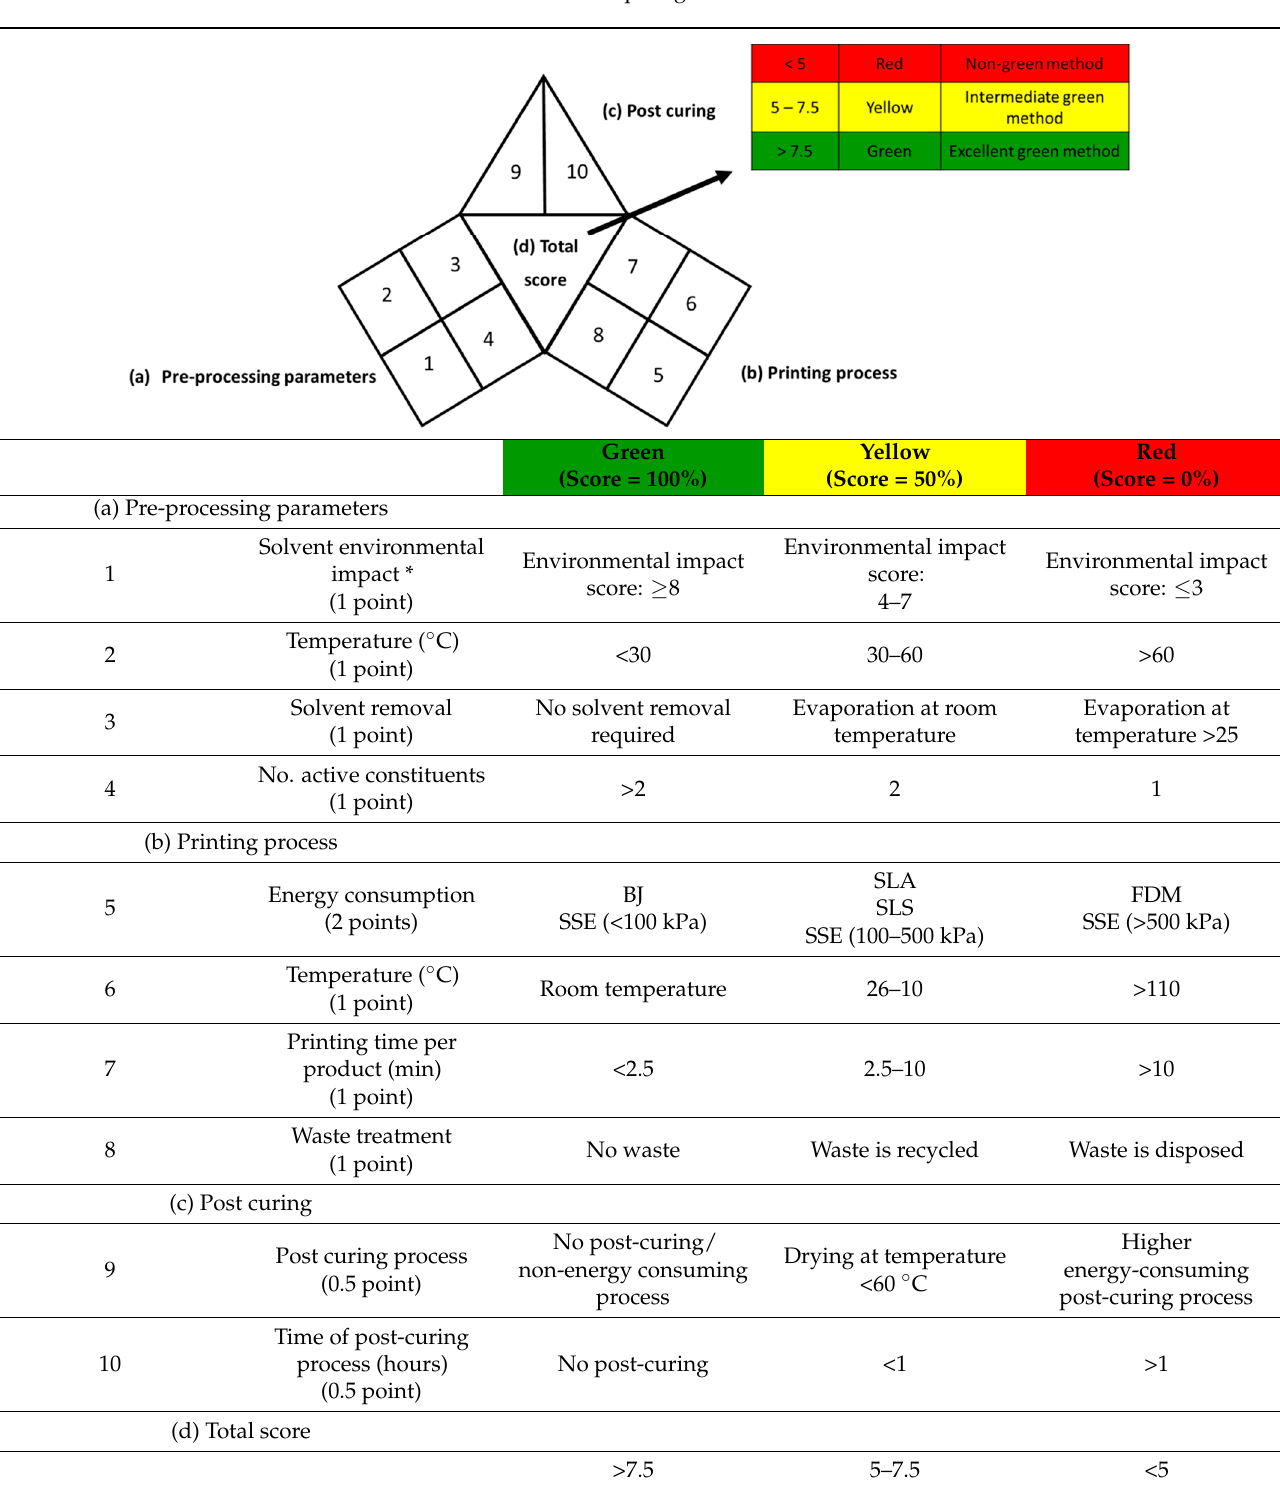
Table 2. Construction of iGAPP pictogram.